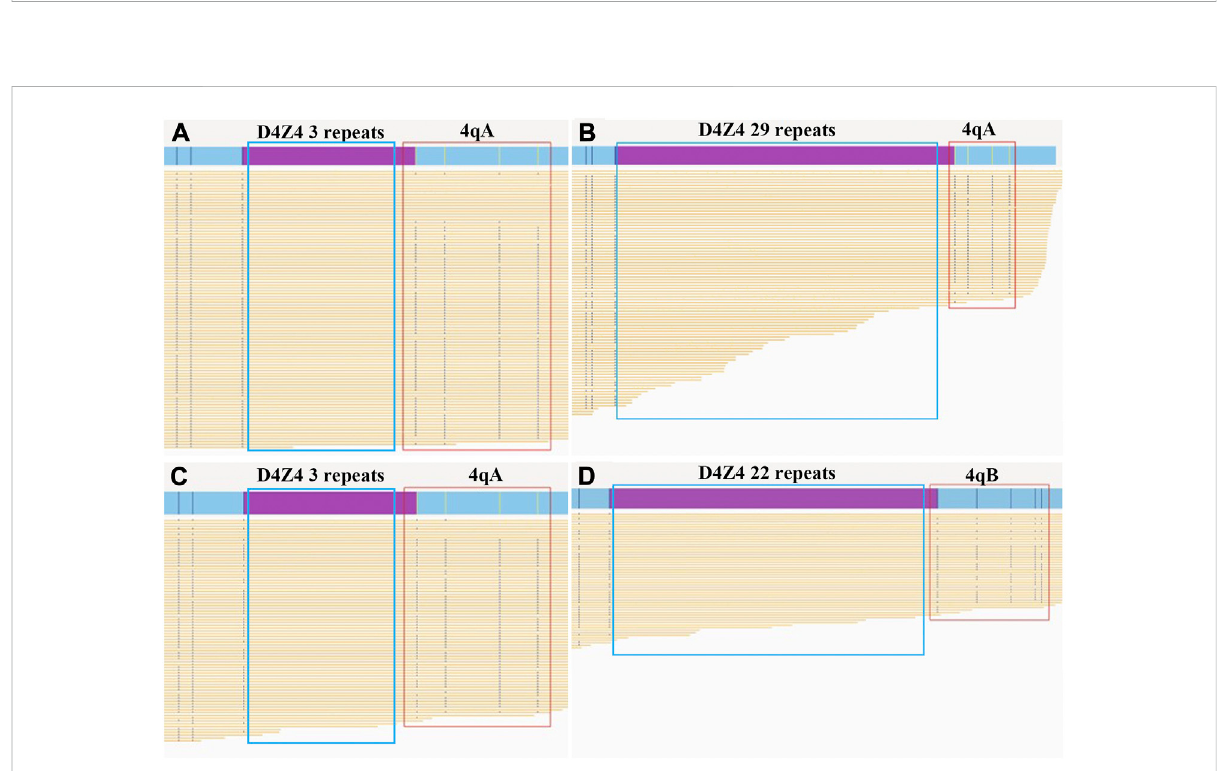
FIGURE 2 Bionano optical maps and genetic diagnosis of the father and fetus. The purple bars show the D4Z4 repeat array in the chromosomal region 4q35. The red boxes indicate the 4qA or 4qB allele. The yellow lines show the reads in the target region produced by Bionano optical mapping. (A) The pathogenic allele (3 D4Z4 repeats with 4qA allele type) in the affected father. (B) The normal allele (29 D4Z4 repeats with 4qA allele type) in the affectedfather. (C) Thepathogenicallele(3D4Z4repeatswith4qAalleletype)inthefetus. (D) Thenormalallele(22D4Z4repeatswith4qBallele type) in the